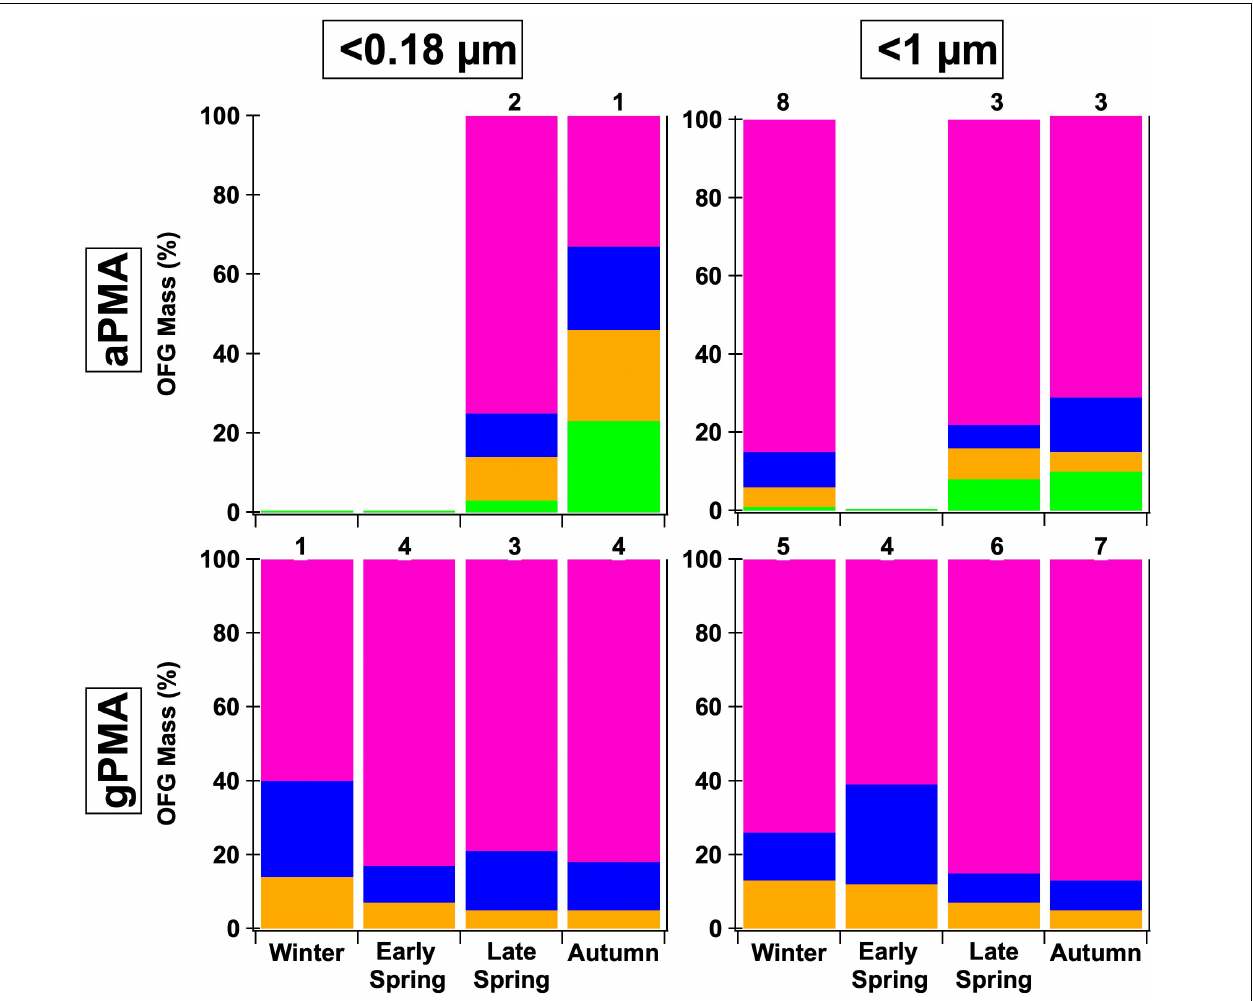
FIGURE 5 | Comparison of two sizes, < 0.18 and < 1 µ m, and two different sampling methods—ambient (aPMA) and generated (gPMA) throughout the four seasons. The average composition percentage is shown with the following functional groups: hydroxyl (pink), alkane (blue), amine (orange), and acid (green) groups. Less than 0.18 µ m aPMA filters have a larger alkane group fraction than the gPMA filters whereas < 1 µ m filters have similar alkane group fractions in both aPMA and gPMA. Numbers above each bar indicate the number of samples available for each average. Less than 0.5 µ m aPMA filters are not included because there are no complementary < 0.5 µ m